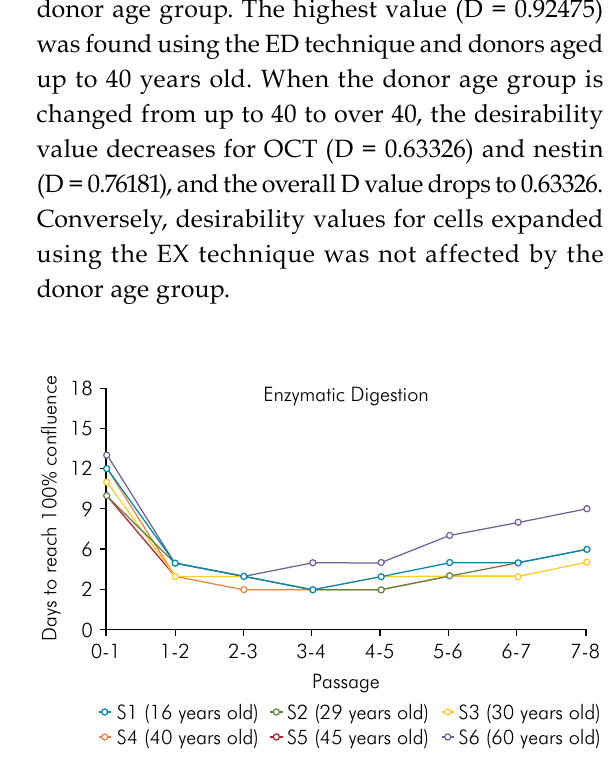
Figure 1. Line graph representative of the days necessary to reach confluence during dental pulp stem cells (DPSC) expansion, considering all donor ages and cell passages, for ENZYMATIC DIGESTION (ED).